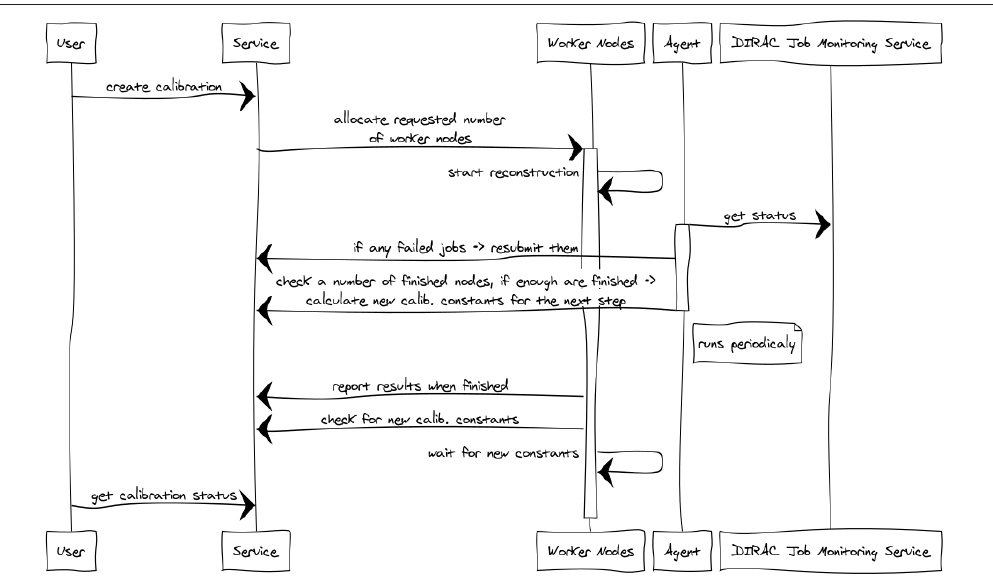
Figure 1: Calibration workflow of the iLCDirac calibration